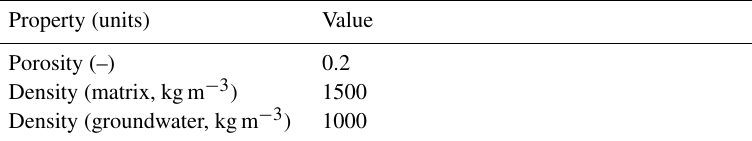
Table A3. Flow and transport parameterization and boundary conditions for all domains in all three flow regimes. The boundary condition for the reactive species was a Dirichlet boundary condition (fixed concentration) at the inlet of the domain. Property (units)